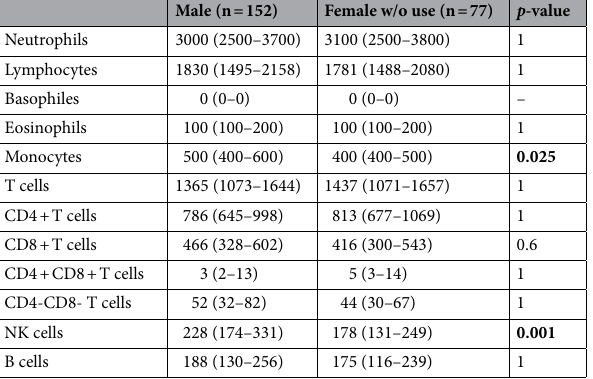
Table 2. Leukocyte proportions between males and females not using contraceptive pill with age and BMI in covariates. p -values are highlighted in bold when significant